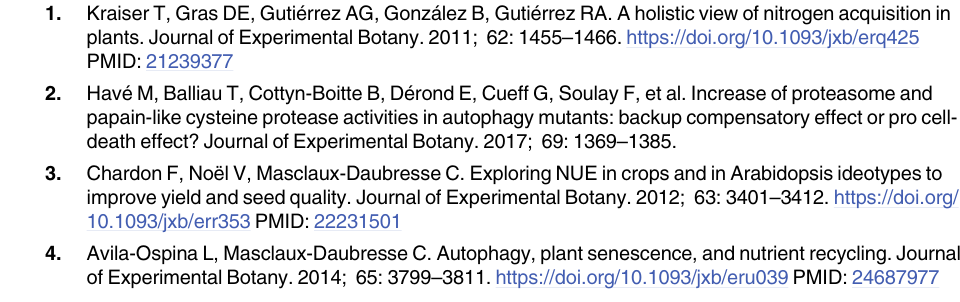
S1 Fig. GUS histochemical staining of Pro -GUS transgenic Arabidopsis at different OsATG8b developmental stages. (A) Seeds in germination; (B) 1-week-old seedlings; (C) 2-week-old seedlings; (D) 4-week-old of mature seedlings; (E) Early inflorescence; (F) Mature inflores- cences and siliques. The left is transgenic Arabidopsis before staining, the right is that after staining. (A) and (B) Bars = 1 mm; (C) and (F) Bars = 5 mm. S2 Fig. Real-time RT-PCR analysis of the transcript levels of AtATG s in 14-day-old seed- lings of WT and 35S-OsATG8b transgenic Arabidopsis under N sufficient condition. (TIF) S3 Fig. Molecular analysis of transgenic lines. PCR identification of genomic. DNA of trans- genic lines. M, Molecular marker DL2000; 1–9, Independent transgenic lines; +, Positive vec- tor containing 35S-OsATG8b plasmid; -, Negative control. S1 Table. The information of primers used in this